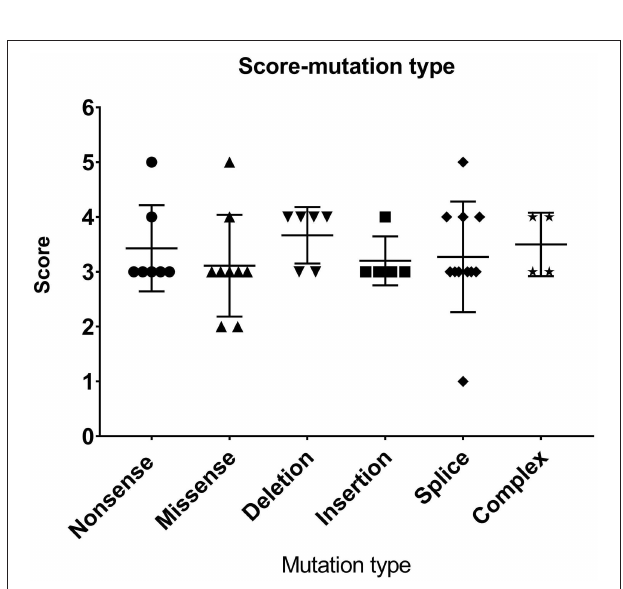
FIGURE 2 | Relationship between mutation type and clinical scores.